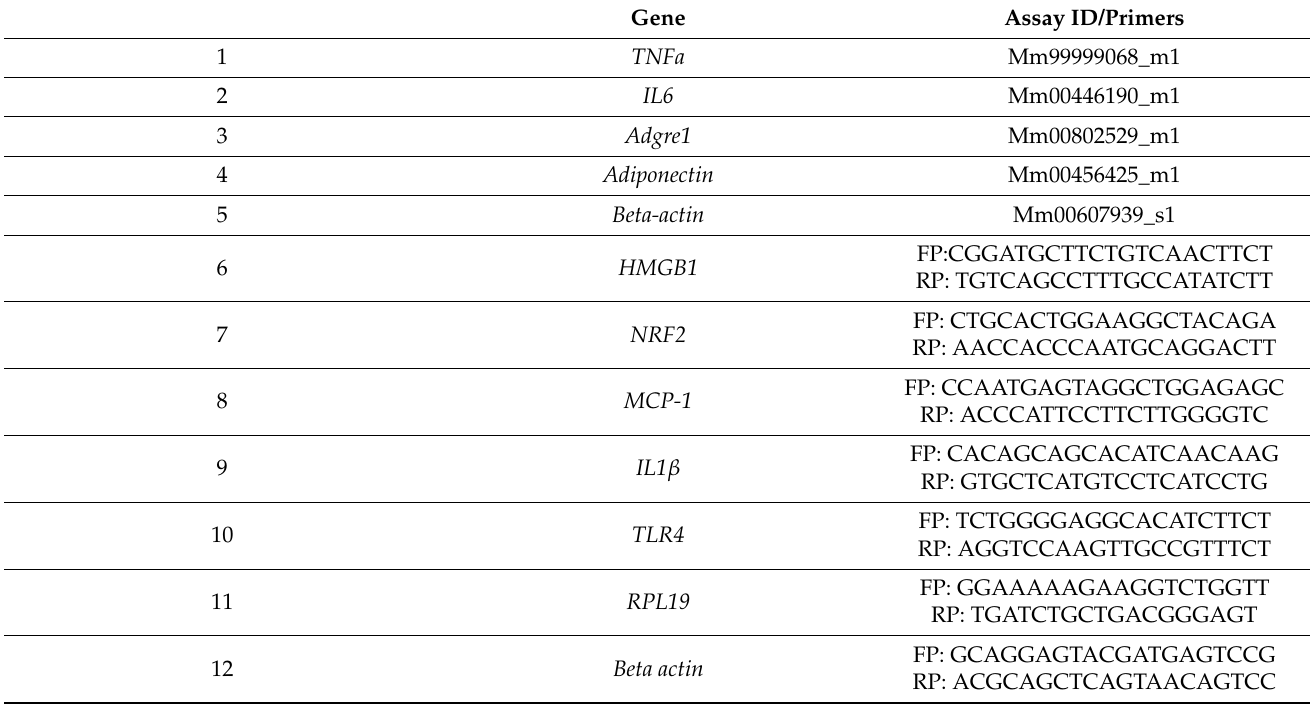
Table 1. Mouse Taqman assays/qPCR primers.